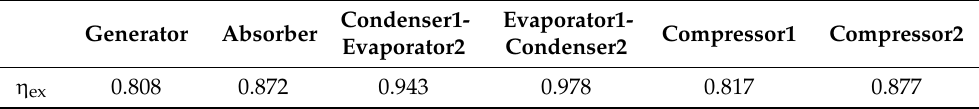
Table 5. Exergy efficiency of components. Condenser1- Generator Absorber